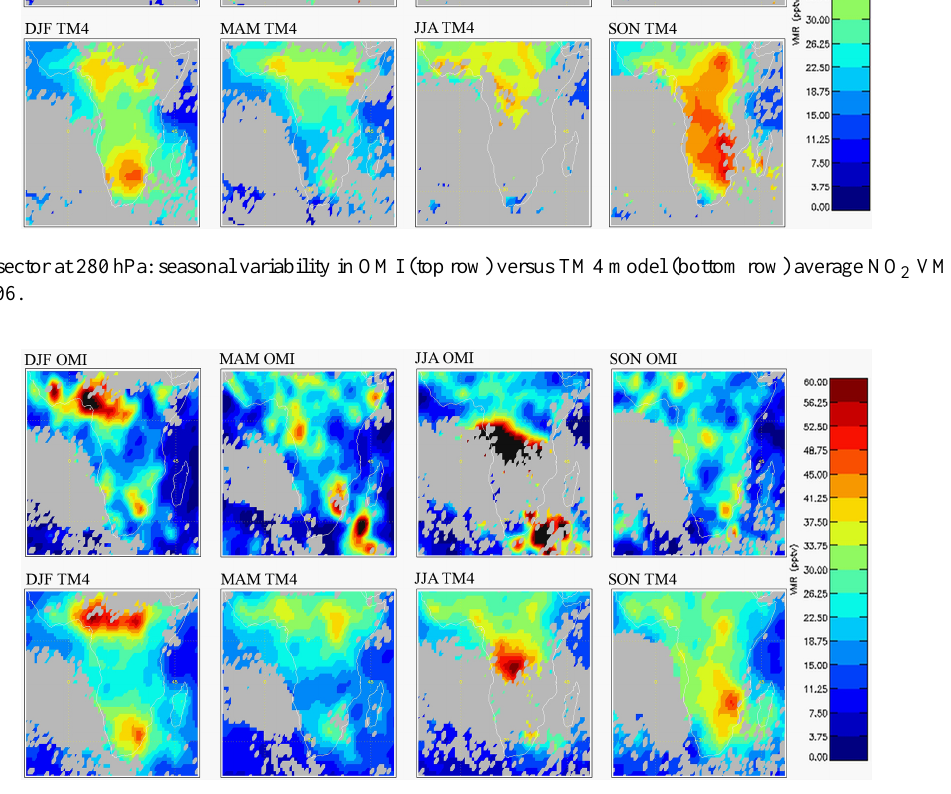
Figure 16. Same as Fig. 15 but at